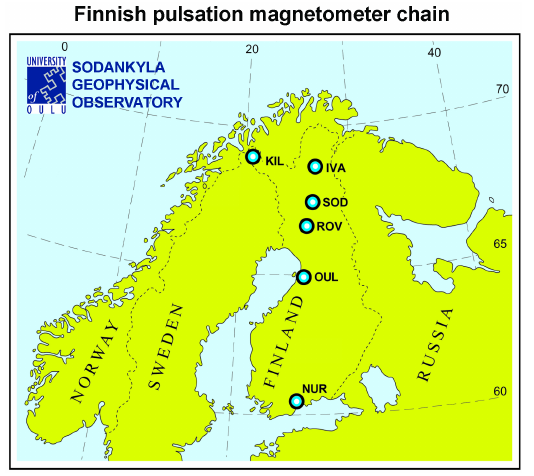
Figure 1. The Finnish pulsation magnetometer chain Fig. 1. The Finnish pulsation magnetometer chain (courtesy of Figure 2. Uncalibrated D component pulsation magnetometer data for 04/10/98 from Sodankyla, Finland displayed as colour dynamic power spectra. Window and slip size are 100 seconds. SGO). Power Spectral density is normalised to peak power at 3 Hz.